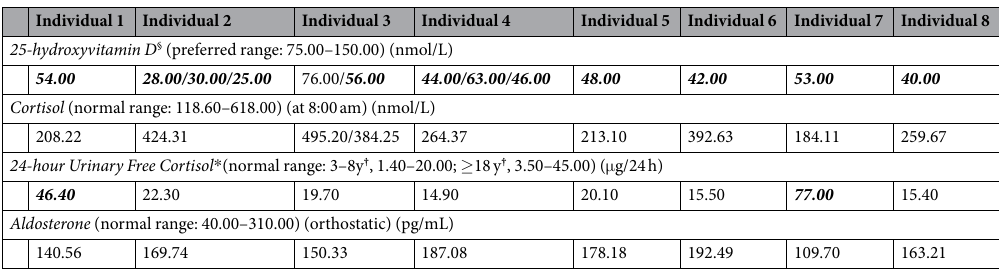
Table 3. Vitamin D and adrenocortical hormones (cortisol and aldosterone) in individuals who are homozygous for p.Ser267Phe in SLC10A1 # . # Forward slash (/) distinguishes tests that were separately performed. § Figures that deviate from the preferred range are in bold italics and are underlined. * Figures that deviate from the normal range are in bold italics and are underlined. † y: